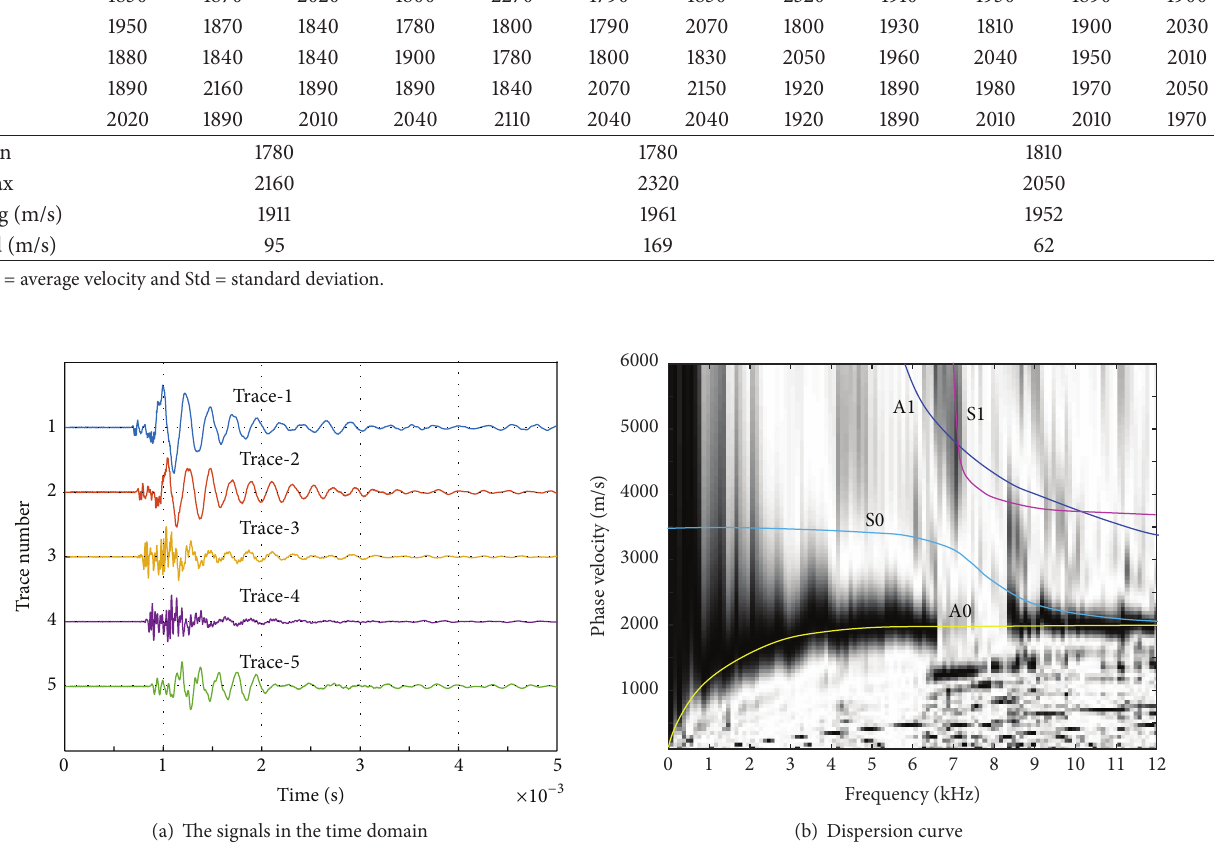
Figure 16: MASW results along the 6th path in slab S2. The computed A0, A1, S0, and S1 Lamb modes corresponding to the slab depth overlap on the dispersion curve